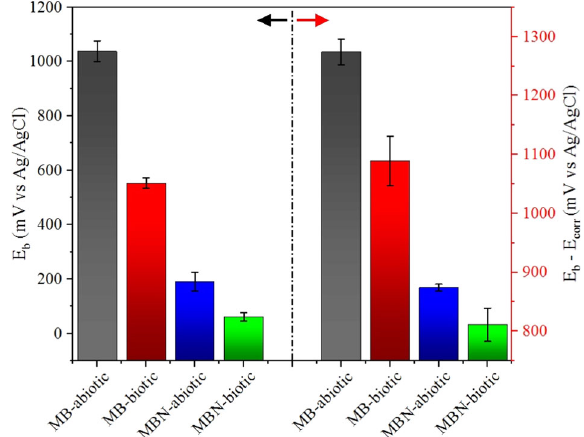
Fig. 9 Passivity breakdown potential of creviced coupons in different test media. Passivity breakdown potential ( E b , left-hand side) and difference between E b and E corr (right-hand side) of creviced 304 stainless steel coupons in MB and MBN test media under abiotic and biotic conditions. Data shown: Mean ± SE; n =